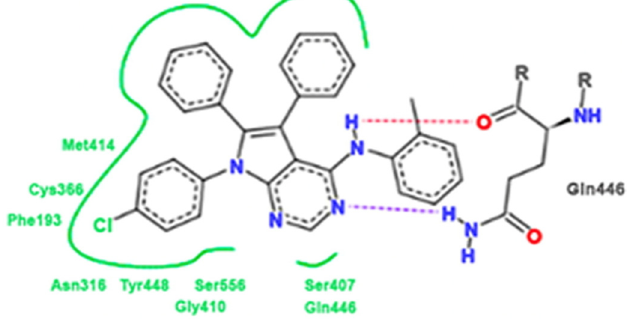
Figure 7. Molecular interaction of compound 39 in the binding site of HCV polymerase [40].